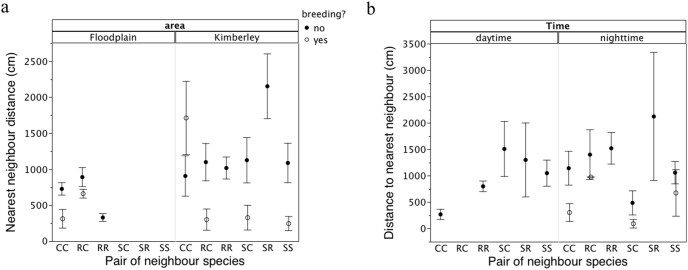
Average distance to the nearest neighbor of anurans.Data show patterns according to the pair of species involved, study site, and occurrence of breeding activity in frogs, at (a) night for surveyed frogs and (b) by day and night for radio-tracked frogs. Bars are standard errors. R = Rhinella marina, C = Litoria caerulea, S = Litoria splendida.